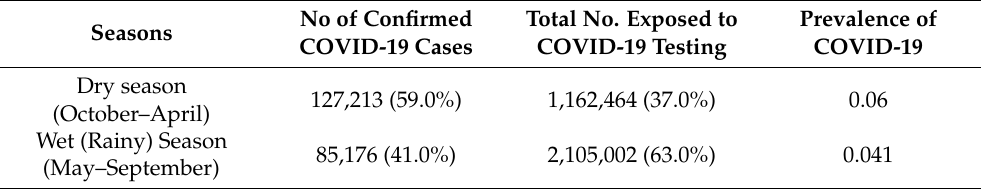
Table 1. Prevalence of COVID-19 during the Dry and Wet Seasons across Nigeria.